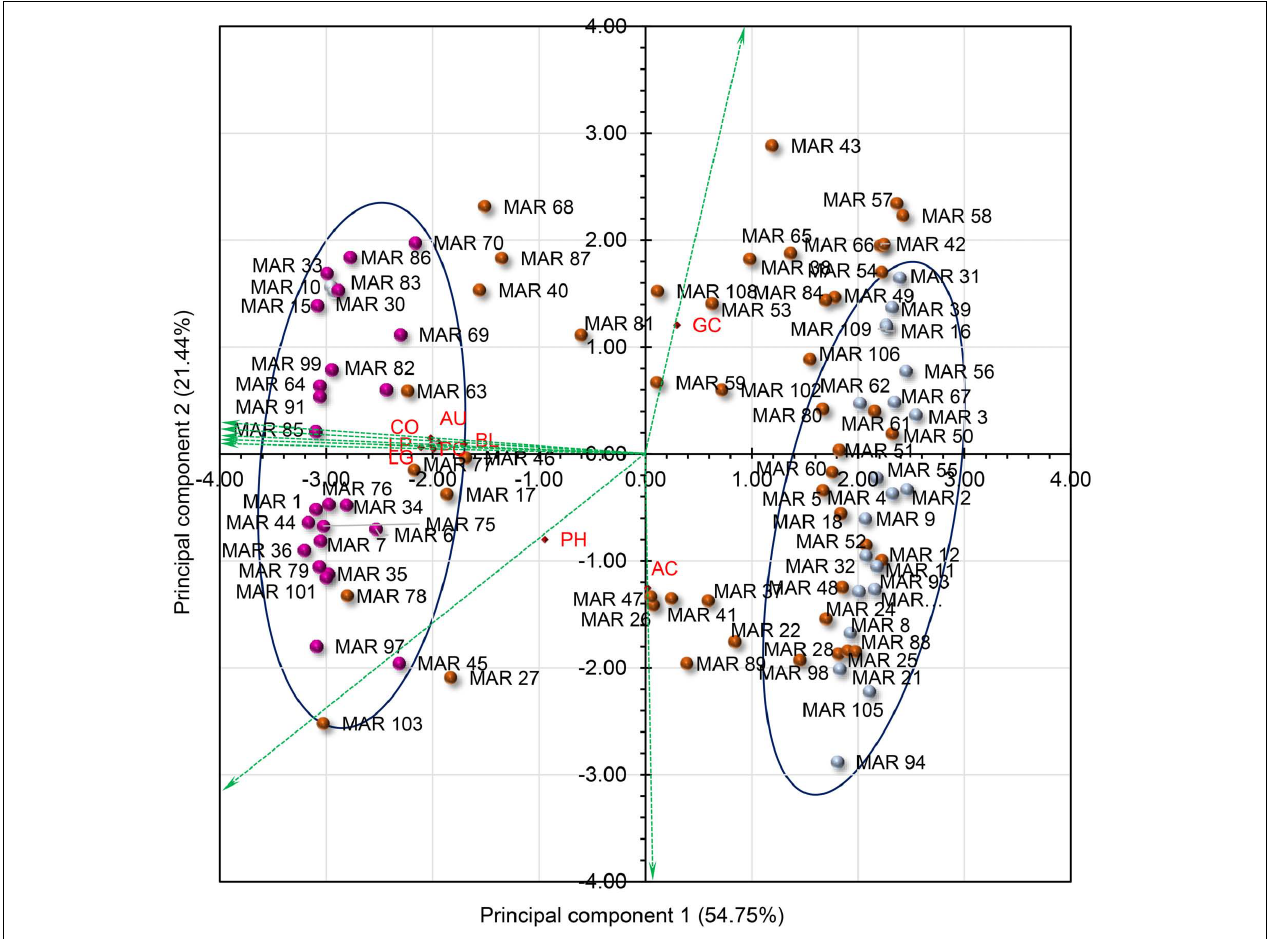
FIGURE 5 | PCA biplot showing the partitioning of Manipur aromatic germplasm using most variable phenotypic traits. There were three groups of genotypes, grouped based on pericarp color. The genotypes with white pericarp (light blue) formed the cluster 1, while deep purple-colored (purple) genotypes formed the second. The third group was intermediate to the first two (brown). The green arrows show the direction of influence of the traits. LG, ligule pigmentation; AU, auricle pigmentation; CO, collar pigmentation; BL, basal leaf color; LP, lemma and palea color; PC, pericarp color; PH, plant height in cm; GC, gel consistency; AC, amylose